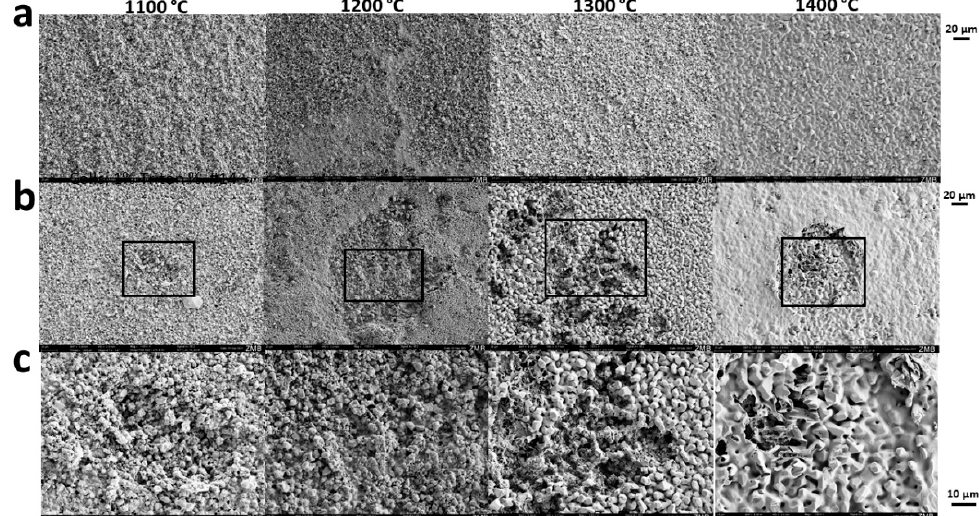
Figure 5. Sintering-temperature dependent osteoclastic degradation of scaffolds. Scanning electron microscopy was performed from scaffolds not exposed to cells ( a ) or seeded and exposed to osteo- clastic RANKL-stimulated RAW264 cells ( b , c ). The maximal sintering temperature is provided at the top of each column. Scales of each panel are provided.